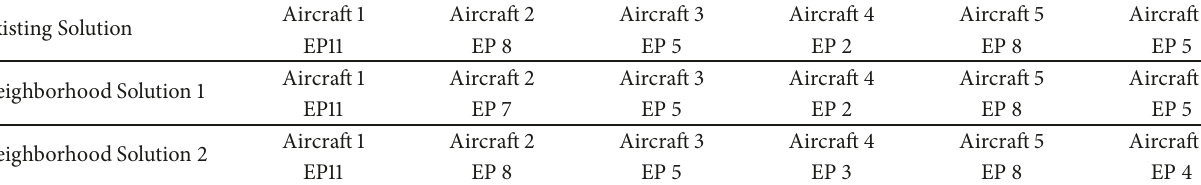
Table 4: Generating neighborhood.